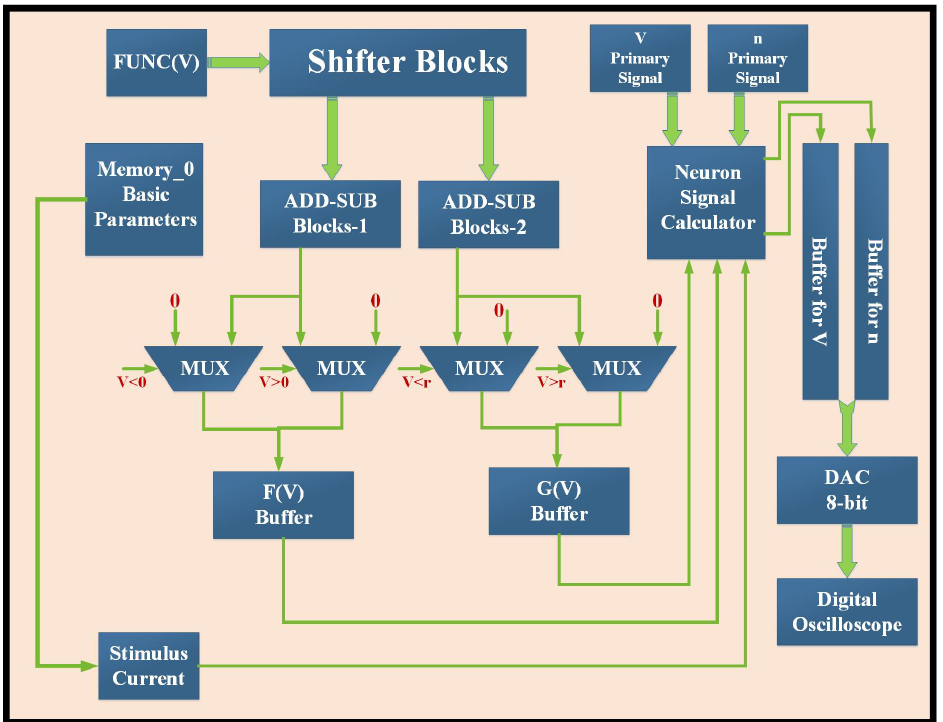
Figure 10. The overall structure of the proposed architecture based on the DSSN equations and scheduling